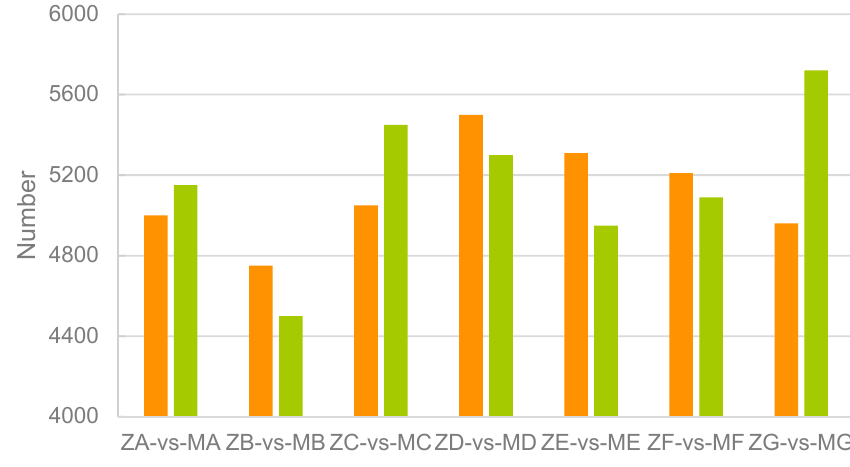
Figure 6. ( a ) General density distribution of P. massoniana and Z pine unigenes by FPKM analysis; ( b ) Pairwise comparison of general density distribution of same stage P. massoniana and Z pine unigenes by FPKM analysis, M: P. massoniana (red curve), Z: Z pine (green curve), A~G: the seven successive stages of pinecone development. X-axis: logarithm to base 10 of FPKM, y-axis: density of distribution.